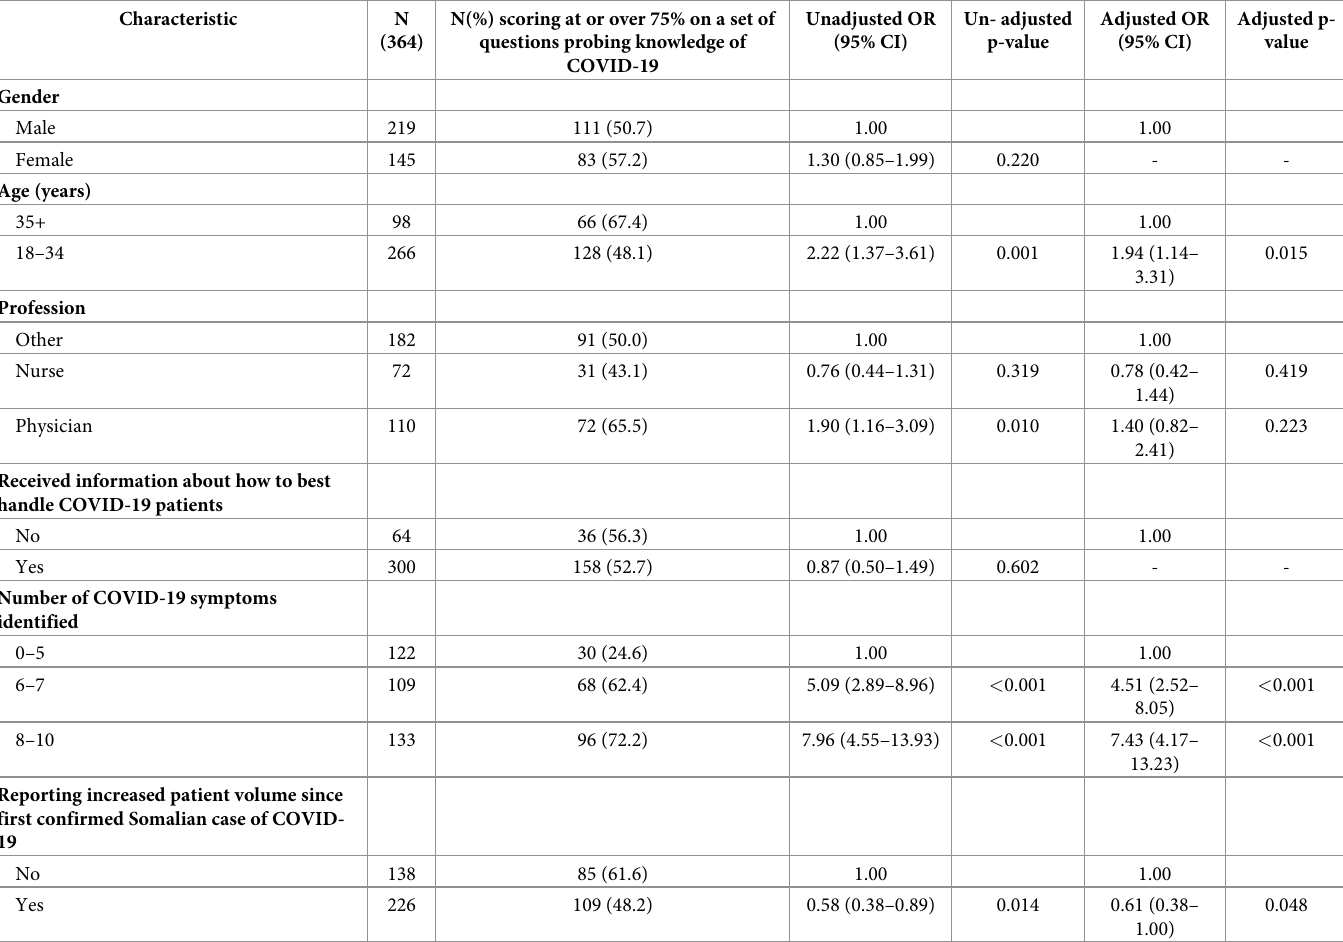
Table 6. Bivariate and multivariable associations between study variables and scores of 75% or higher on a set of questions probing knowledge of COVID-19 among Somali healthcare workers.